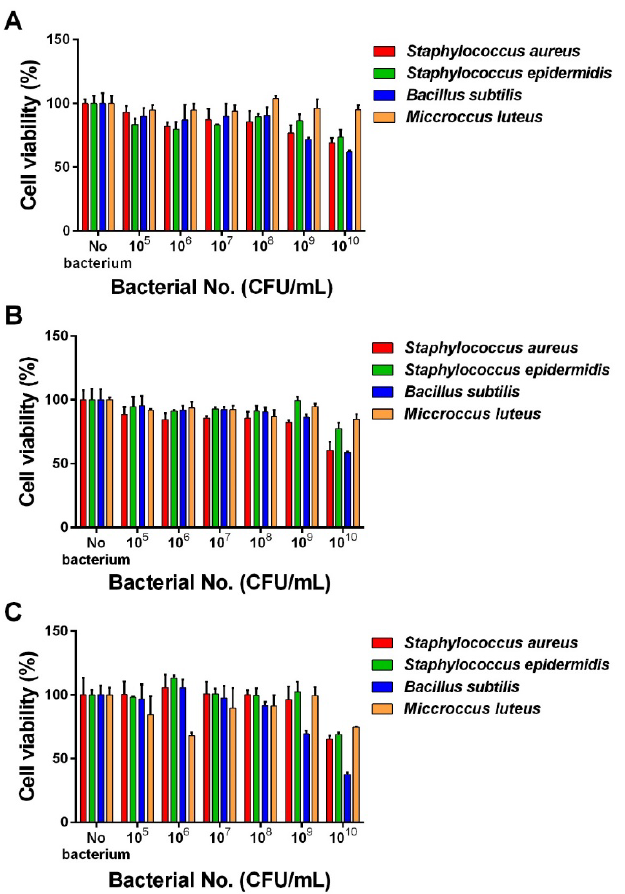
Figure 2. In vitro evaluation of bacterial toxicity in human cells. Effects of four species of bacteria on the viability of MRC5 ( A ), HeLa ( B ), and YD38 ( C ) cells analyzed by the MTT assay 24 h after the bacterial samples were added to human cells pre-seeded in 96-well plates. Results are expressed as cell viability as a percentage of cells incubated without bacteria. Experiments were repeated twice, with each condition being assessed in triplicates. Data are shown as the mean ± SD. CFU; colony forming